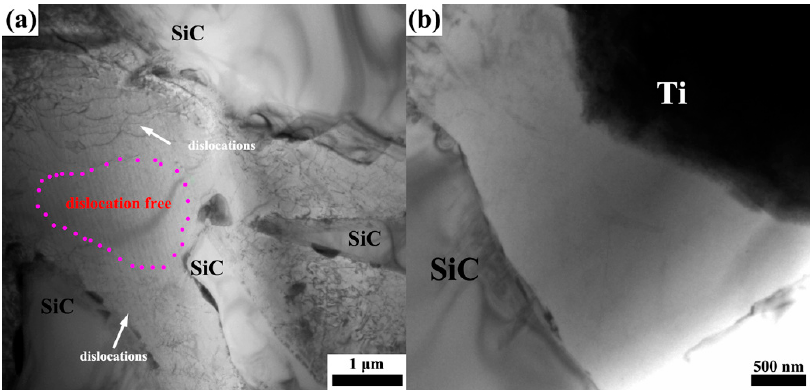
AMC-SiC hybrid composites; and ( d – f ) fracture surfaces of AMC-Ti hybrid composites.